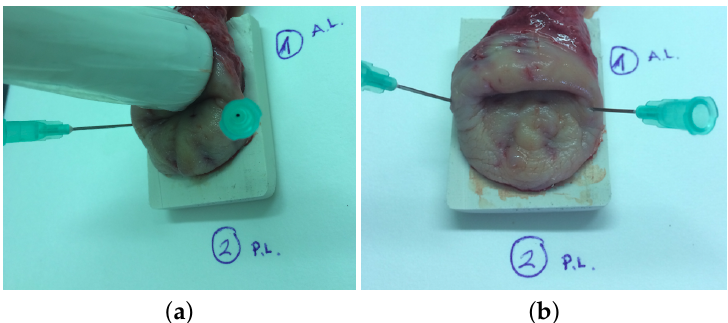
Figure 4. ( a ) measurement with the torsional wave sensor of a cervical tissue sample; ( b ) cervical tissue